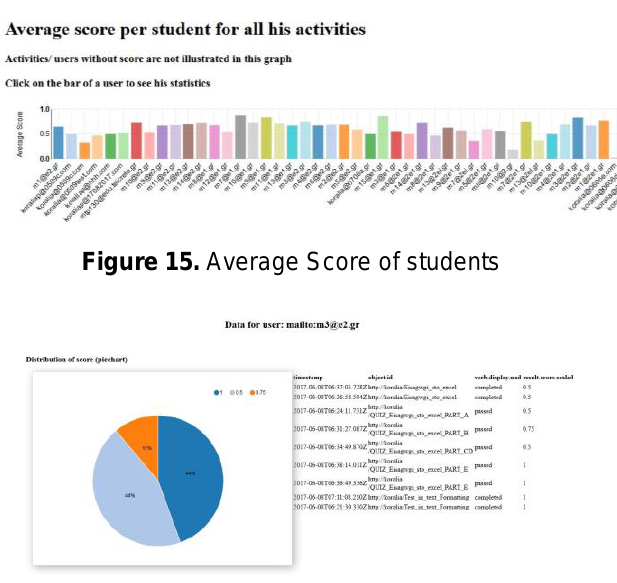
Figure 16. Analytics for an individual